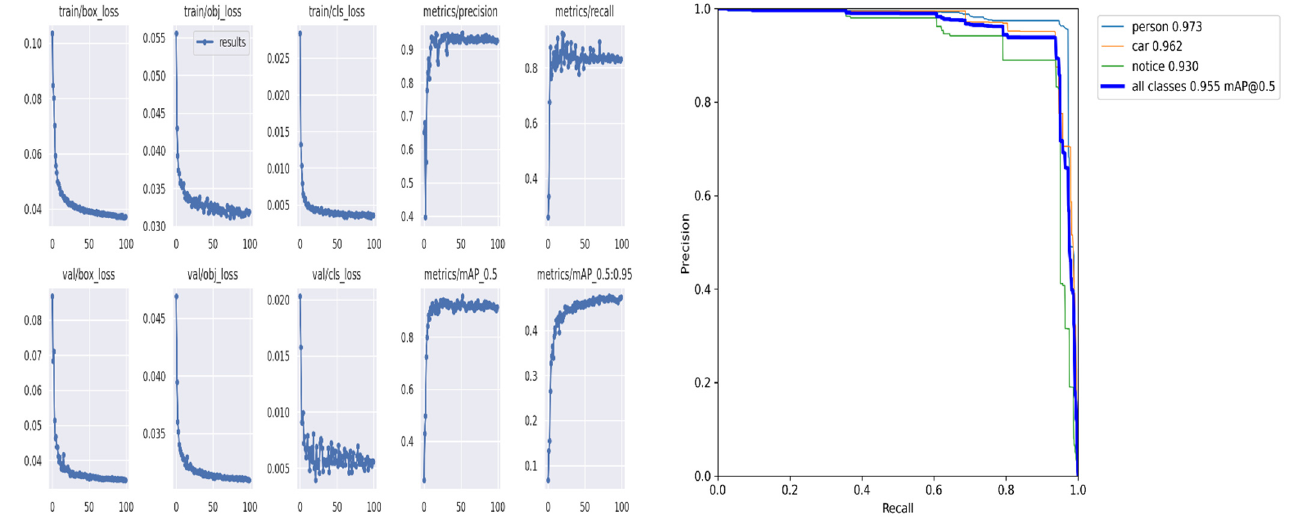
Figure 12. Graph of result values for YOLOv5_Ours model. ( Left figure is changes in key indicators